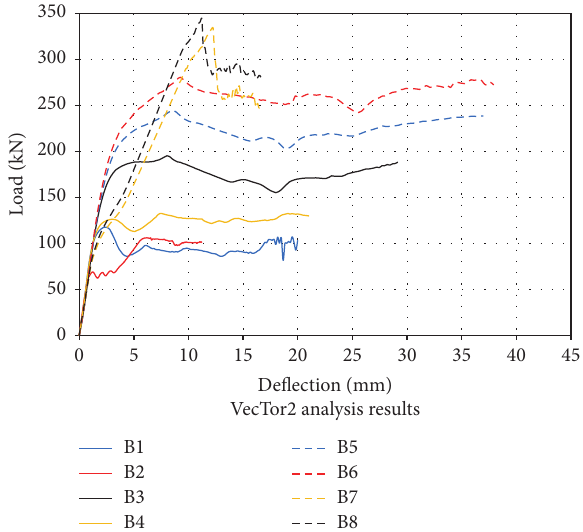
Figure 19: Load-deformation relationships for R-SC-ECC